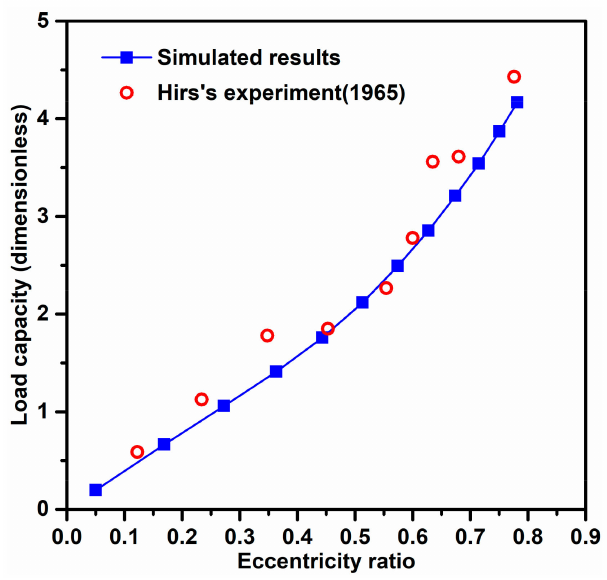
Figure 9. Comparison of simulated load capacity with experimental data of Hirs et al.